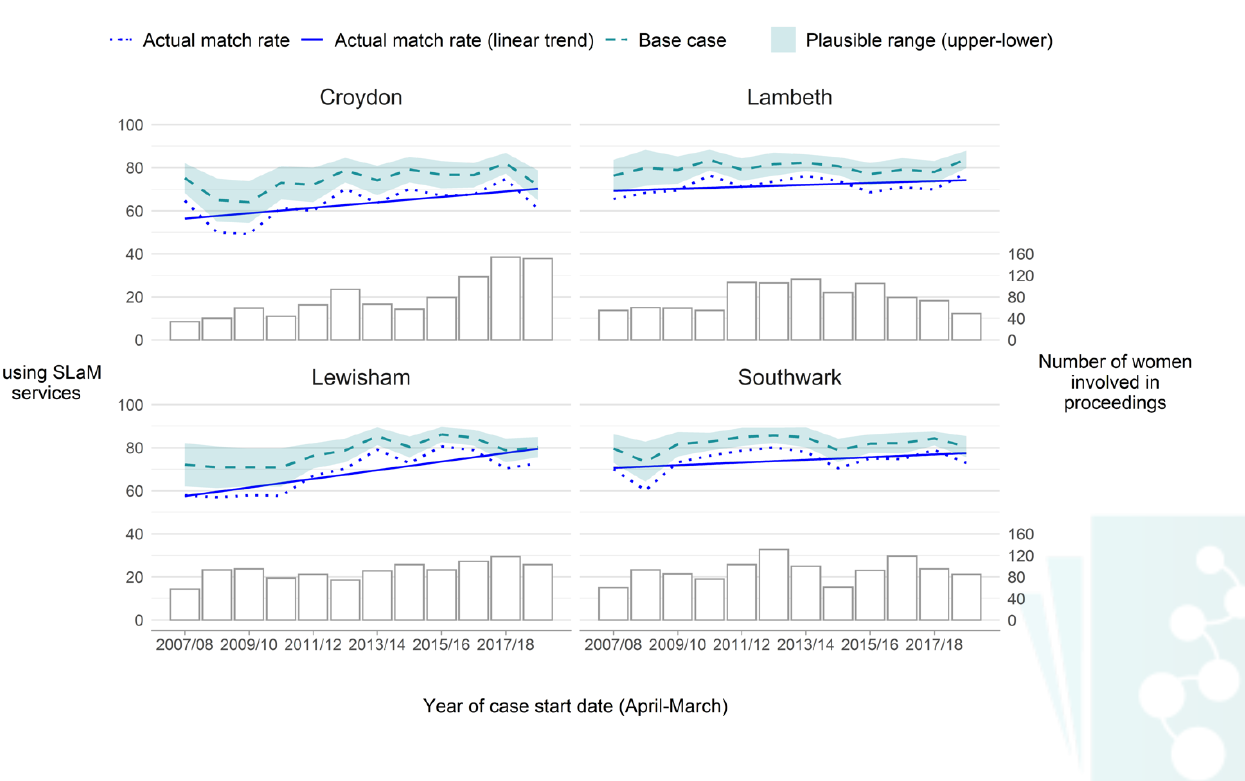
Figure 4: Trends in the estimated prevalence of SLaM mental health or substance misuse service use among women involved in care proceedings in Croydon, Lambeth, Lewisham and Southwark over